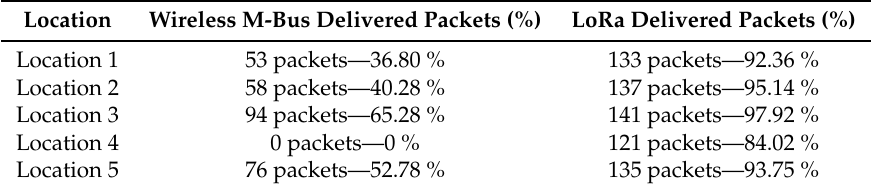
Table 3. Wireless M-Bus and LoRa data delivery